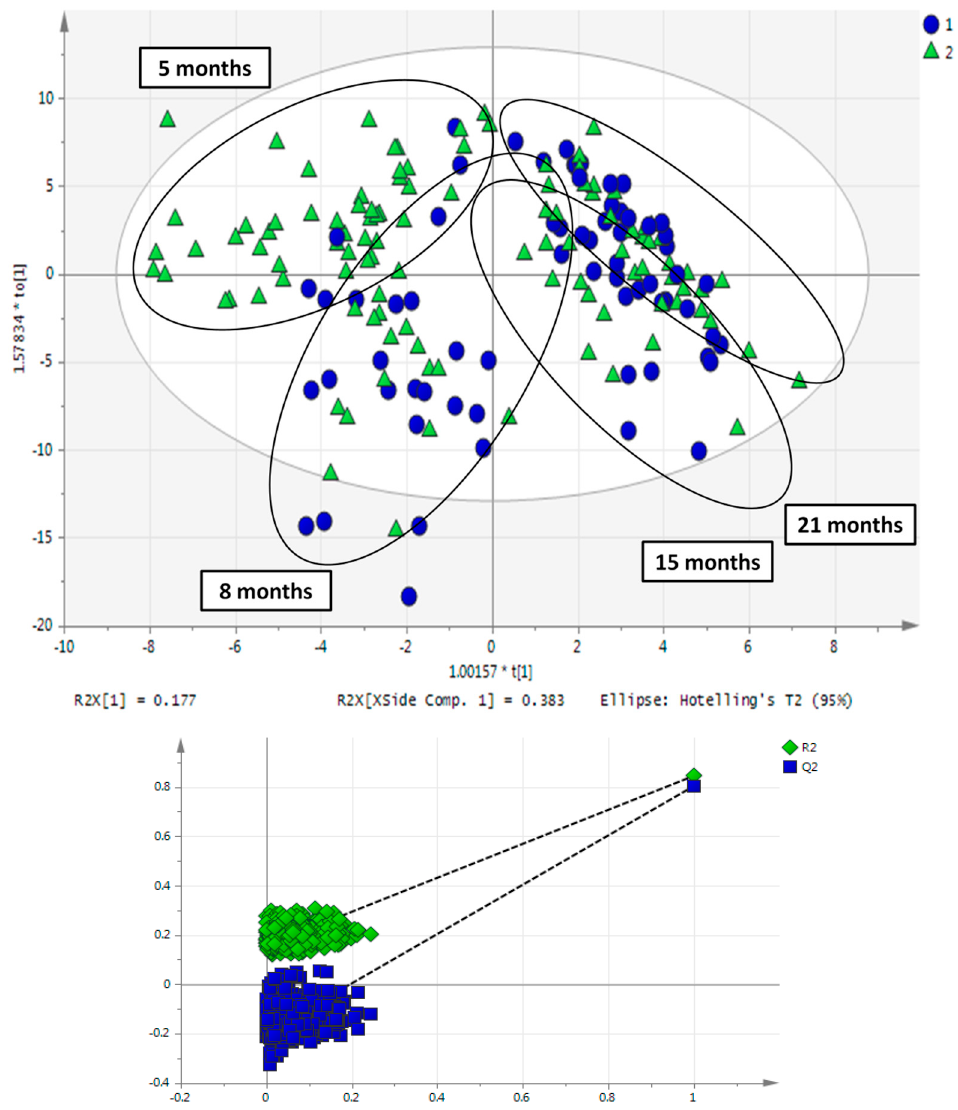
Figure 5. OPLS scores plot of rat urine samples of four sampling time points, corresponding to 5, 8, 15 and 21 months of rat age. Sedentary rats are in blue and exercise in green. It can be seen that the aging factor is distinct while the training rat samples cannot be differentiated from controls when samples from all ages/sampling points are considered for statistical analysis.